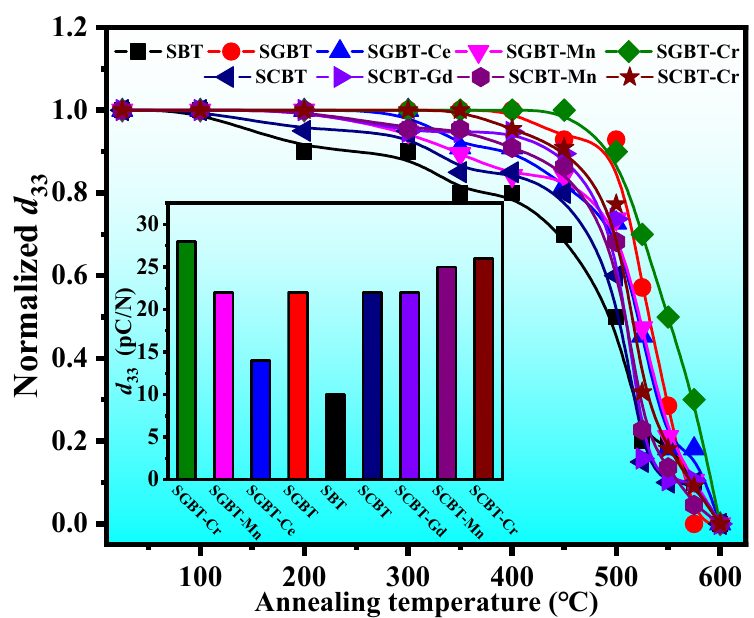
Figure 6. Thermal stability of piezoelectricity of the oxide-modified SBT ceramics (the insert shows the d 33 values of various compositions at room temperature). Table 4. Comparison of electrical properties between the oxide-modified SBT ceramics and other compositions reported.